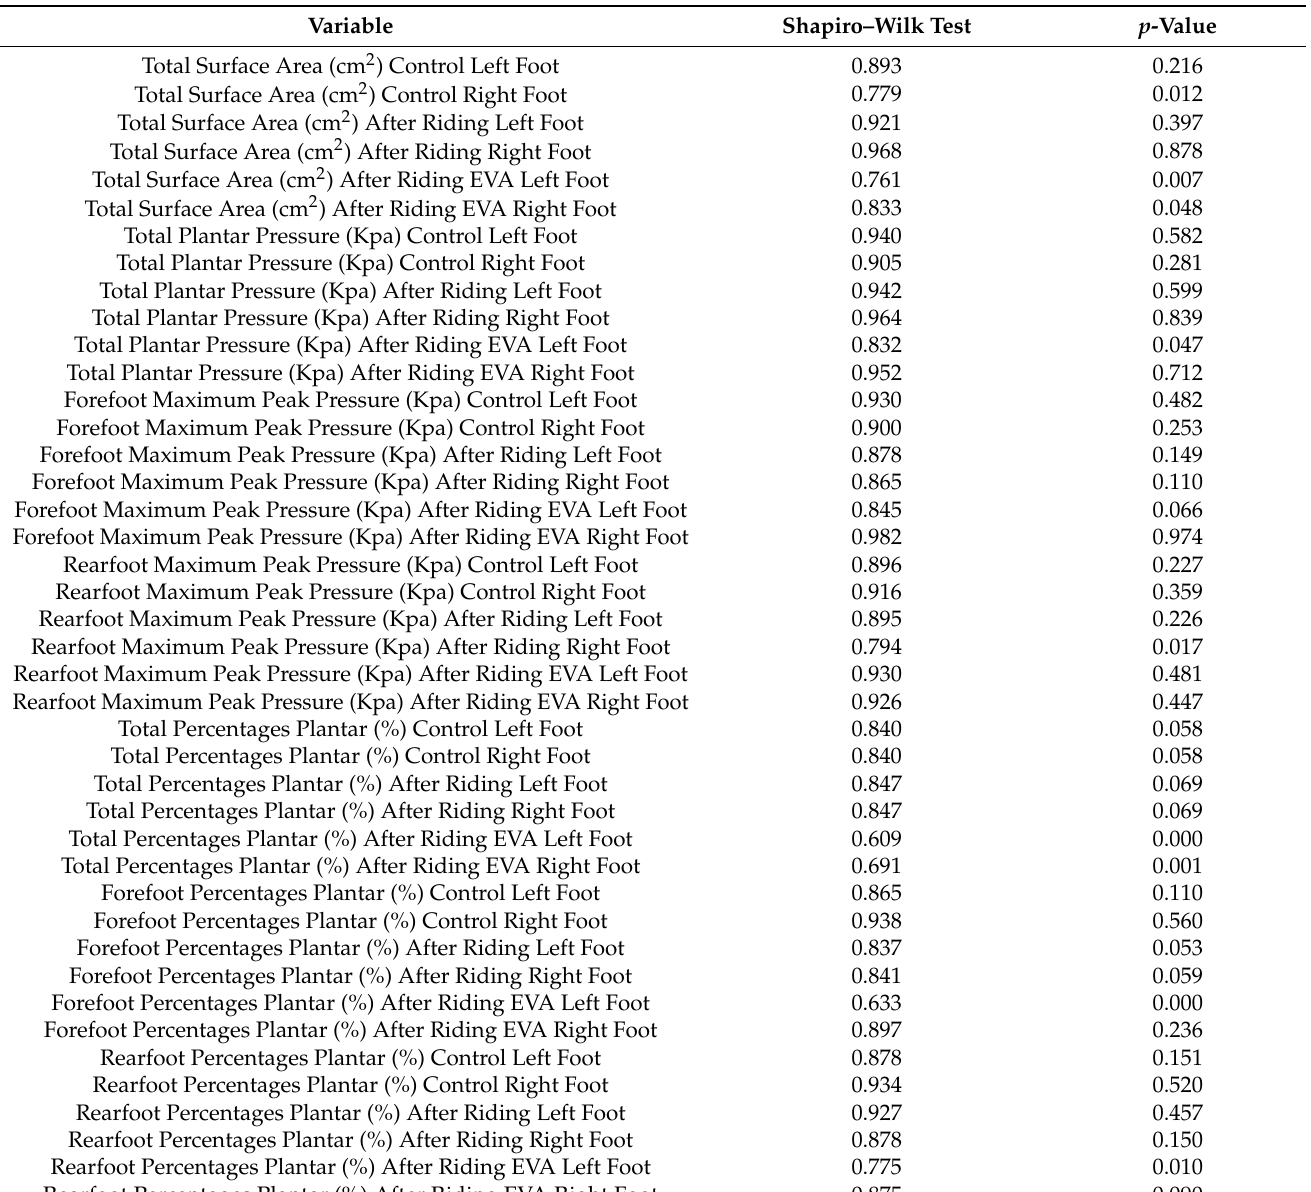
Table 2. Baropodometric plantar normality values performed in right and left foot before riding on a Supersport motorcycle, after riding on a Supersport motorcycle and after riding with an EVA insole on a Supersport motorcycle.